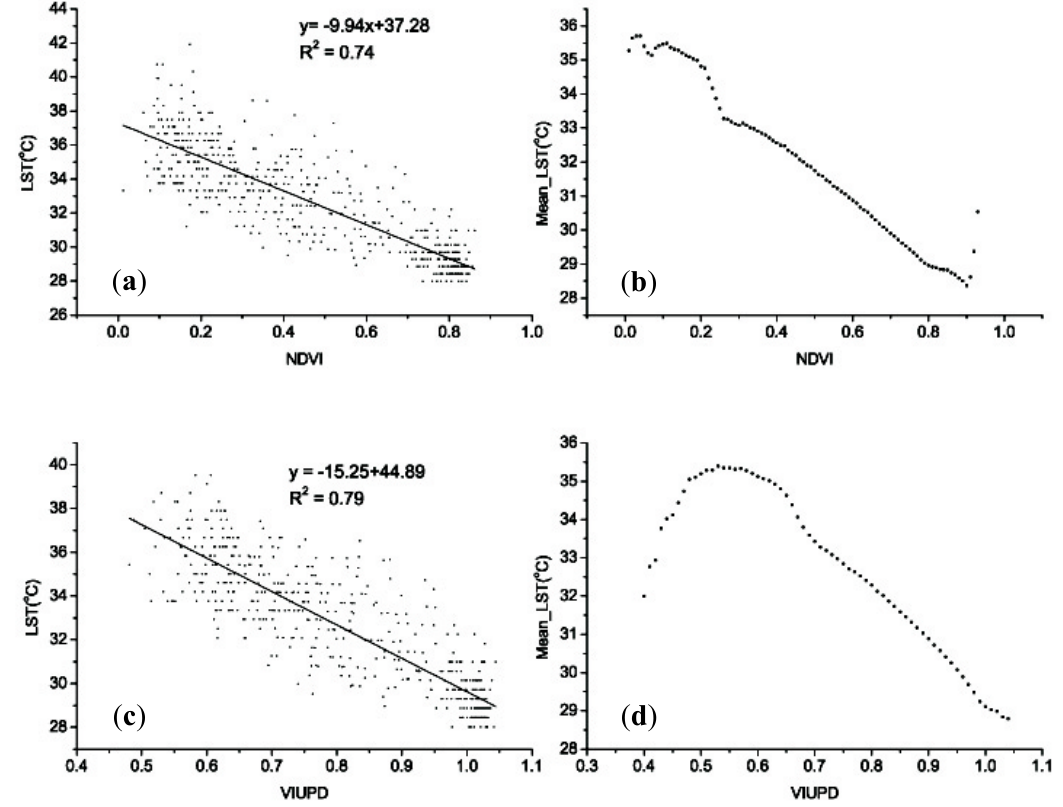
Figure 7. Scatterplot of LST versus the remote sensing indexes on 15 August 2010 ( a ) Scatterplot of LST vs. NDVI; ( b ) Scatterplot of mean LST vs. NDVI; ( c ) Scatterplot of LST vs. VIUPD; and ( d ) Scatterplot of mean LST vs.